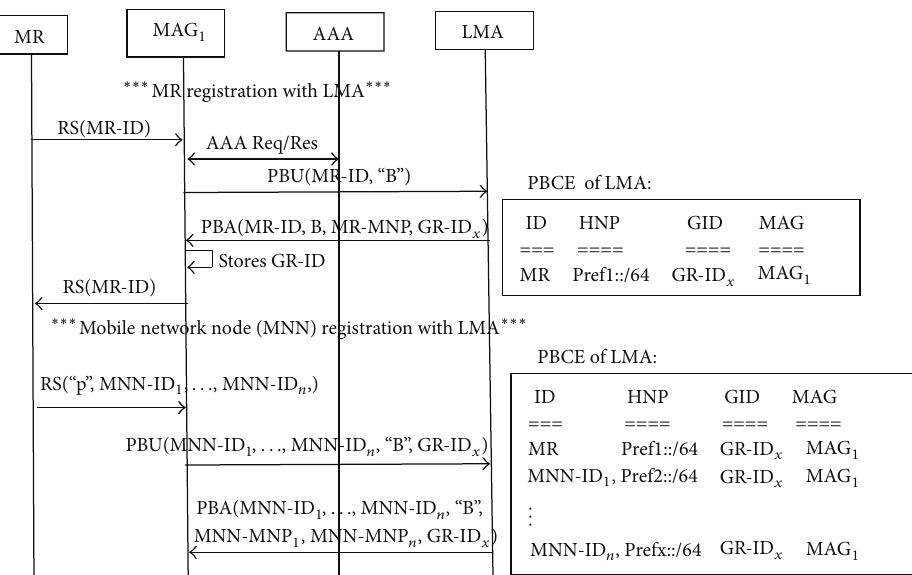
Figure 1: Registration of mobile network with PMIPV6